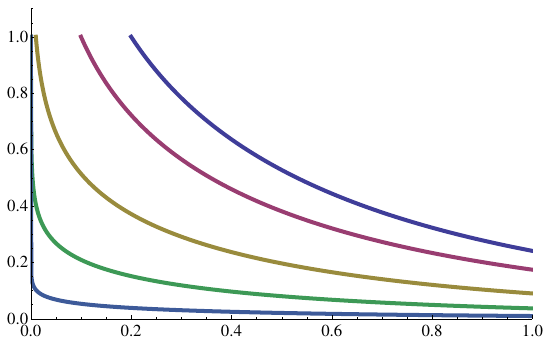
Figure 11 . Edge state mode function (cid:30) k ( (cid:26) ) as (cid:15) ! 0 + . (cid:15) decreases from top to bottom. The pro(cid:12)le gets squeezed on the horizon as (cid:15)